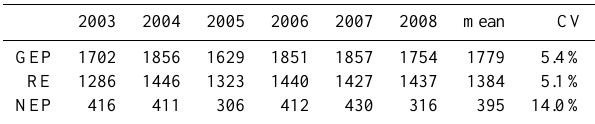
Table 2. Annual CO 2 fluxes of QYZ site during 2003–2008 (gCm − 2 yr − 1 )